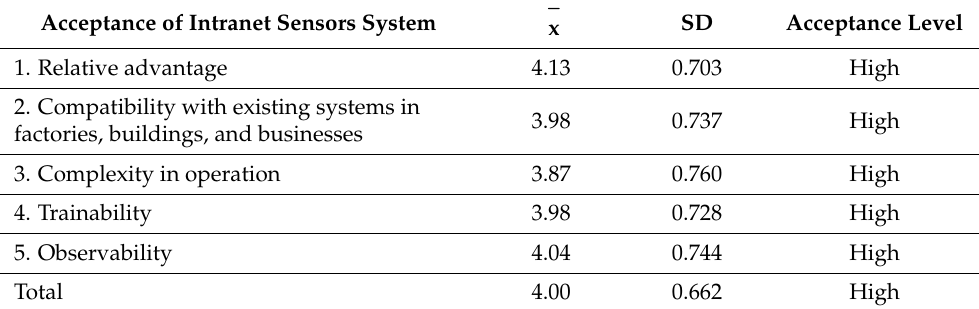
Table 2. Analysis of feedback on the acceptance of internet applications for the management of electrical switchboards.